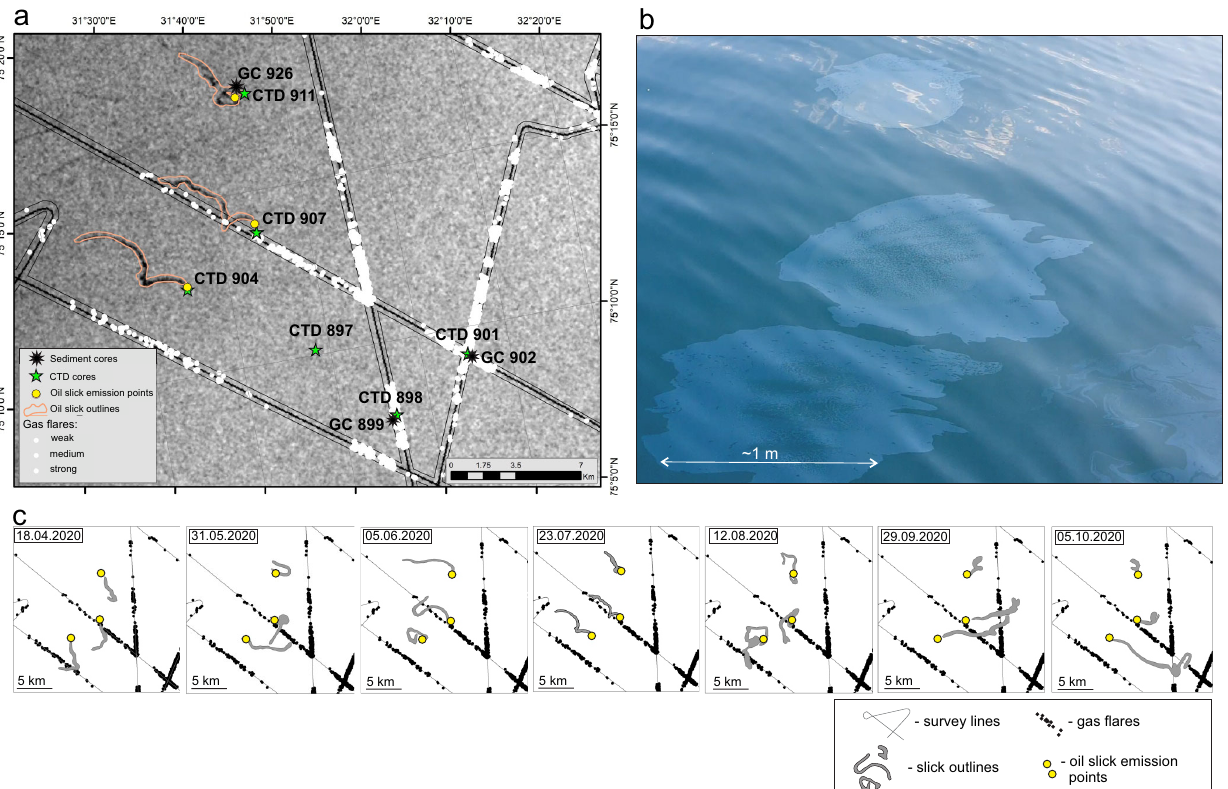
Fig.5|Indicationsofmethanegasandoilinseawater.a Syntheticapertureradar (SAR) image s1b-ew-grd-hh-20200723t051748 (Copernicus Sentinel data 2020, processed by ESA) of oil slicks on sea surface and locations of gas fl ares, water sampling stations, and sediment cores. b Photograph of oil fi lms taken during oil